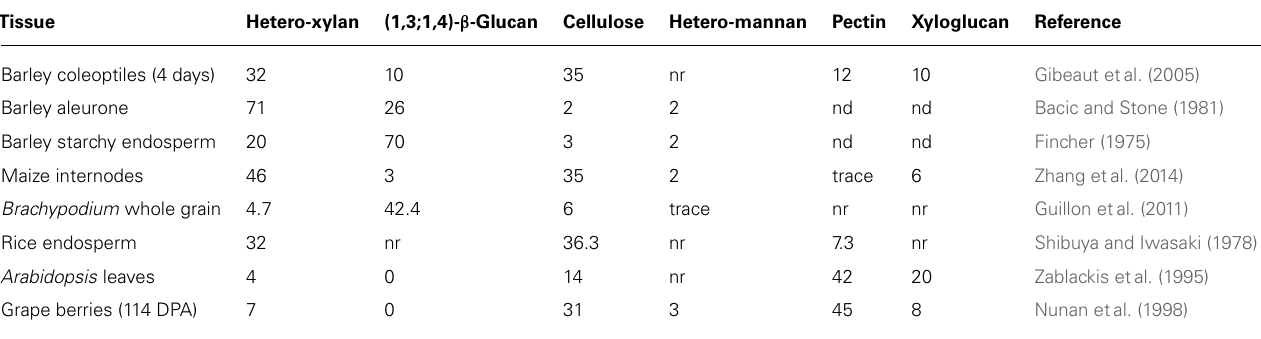
Table 1 | Selected comparisons of polysaccharide compositions in walls of vegetative tissues, fruit, and grains/seeds (% w/w).